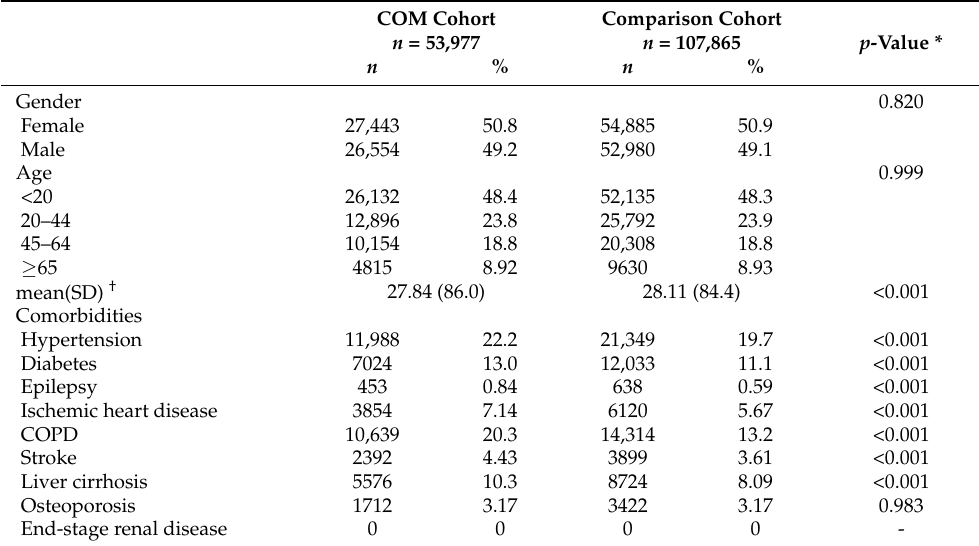
Table 1. Demographic profiles for the COM and comparison cohorts.